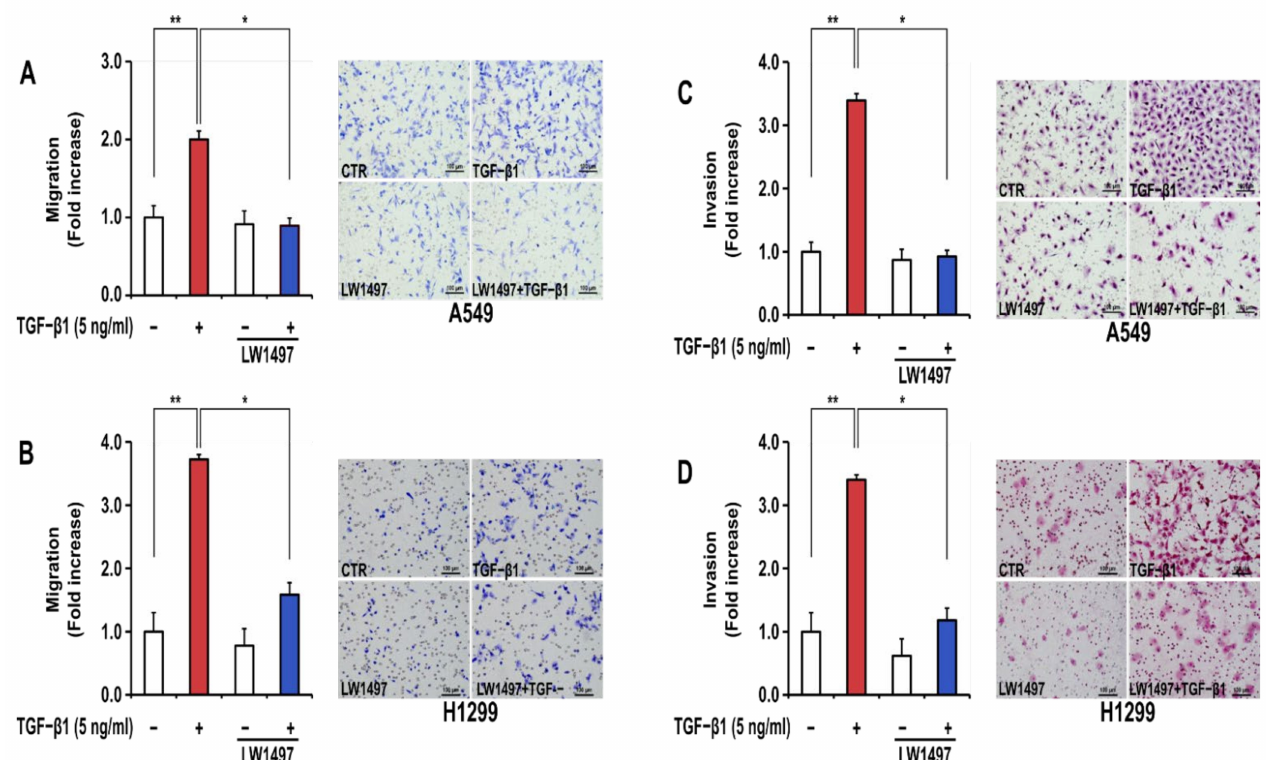
Figure 2. LW1497 inhibited TGF- β 1-induced migration and invasion in A549 cells. ( A , B ) A549 ( A ) and H1299 ( B ) lung cancer cells treated as in Figure 1 were seeded on 8 µ m pore Transwell chambers. Transmigrating cells were stained with Diff-Quick ® stain reagents and counted for each of the indicated cells. ( C , D ) A549 ( C ) and H1299 ( D ) lung cancer cells were added to the inside of the Transwell insert. Transinvading cells were stained with hematoxylin and eosin and counted for each of the indicated cells. Three independent experiments were performed for the results of migration and invasion assay. A * p value <0.05 and **, p value < 0.01 were considered significant and Error bars, ± SD. To compare the ratio between the control and the experimental groups, the fold change was calculated based on the